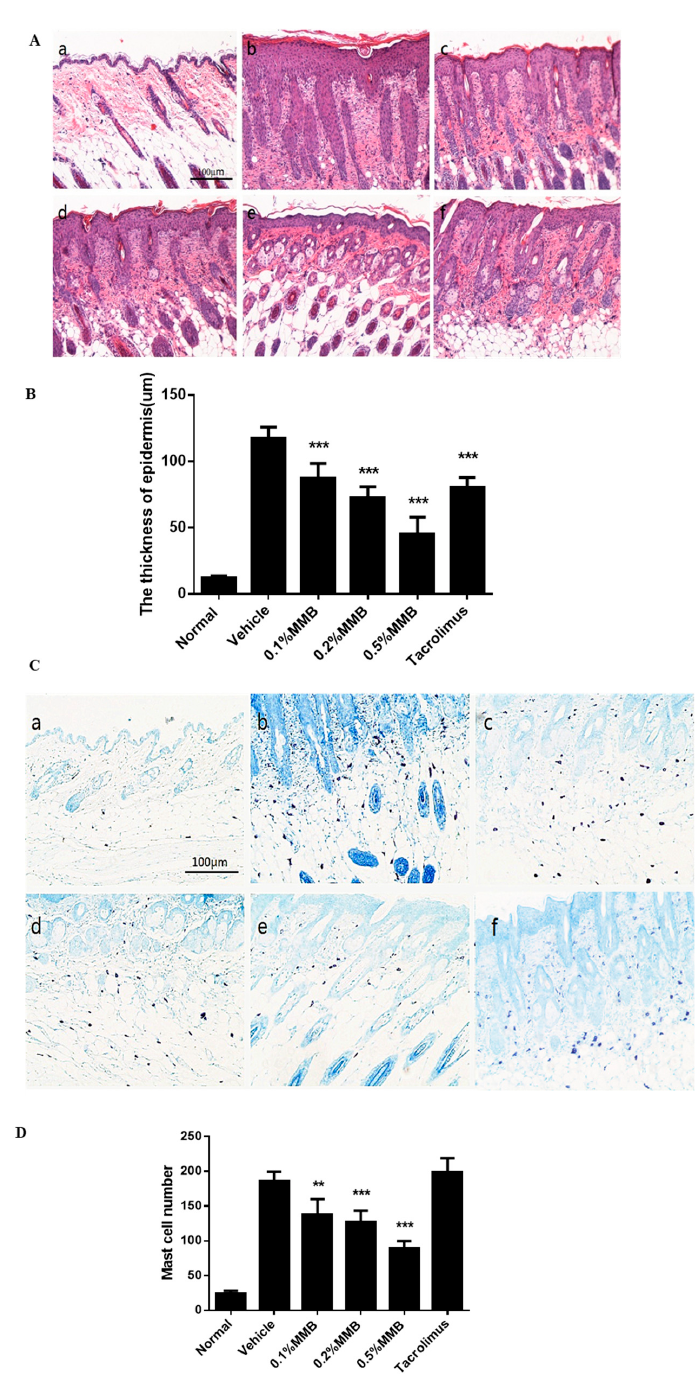
Figure 2. Skin lesions were stained with H&E and toluidine blue ( × 100 magnification, A , C ) to represent the thickness of epidermis and number of mast cells respectively ( × 200 magnification, B , D ). ( a ) The normal group, ( b ) the vehicle group, ( c ) the 0.1% MMB group, ( d ) the 0.2% MMB group, ( e ) the 0.5% MMB group, and ( f ) the tacrolimus group. Values are mean ± SD ( n = 6). ** p < 0.01, *** p < 0.001 versus the vehicle group.